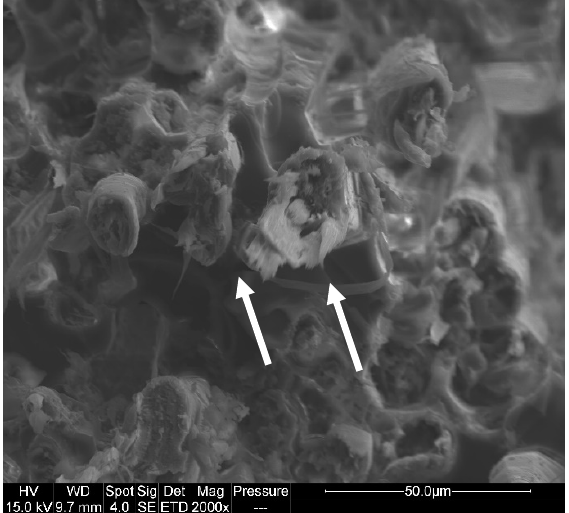
Figure 10. SEM picture of fracture surface of EpFl-AlPi after immersion in liquid water. Arrows indicate the tear of fiber external cell wall.